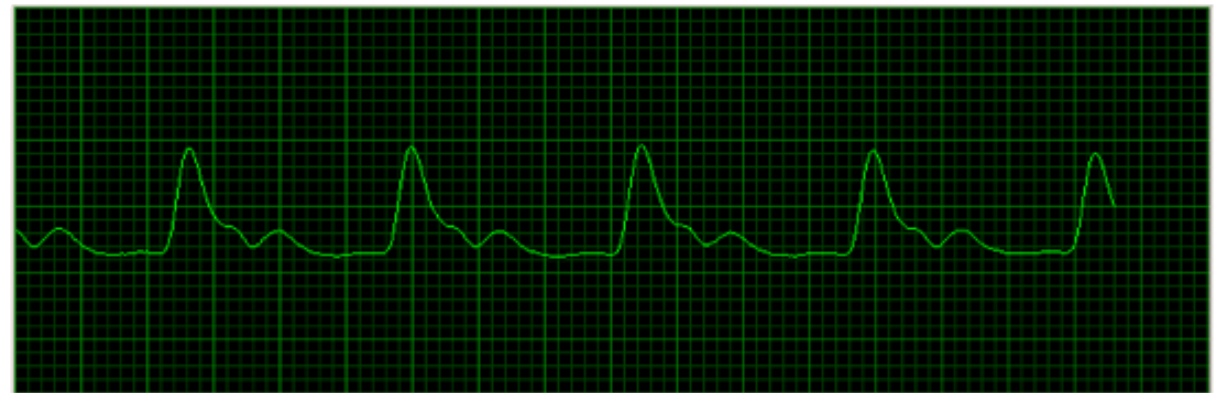
Figure 3. The pulse wave image